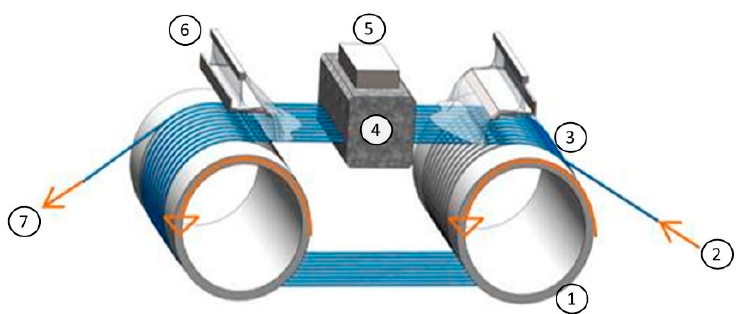
Figure 1. Wire guide rollers; 2: Fresh wire; 3: Wire web; 4: Workpiece; 5: Top plate; 6: Slurry nozzles; 7: Used wire [5].